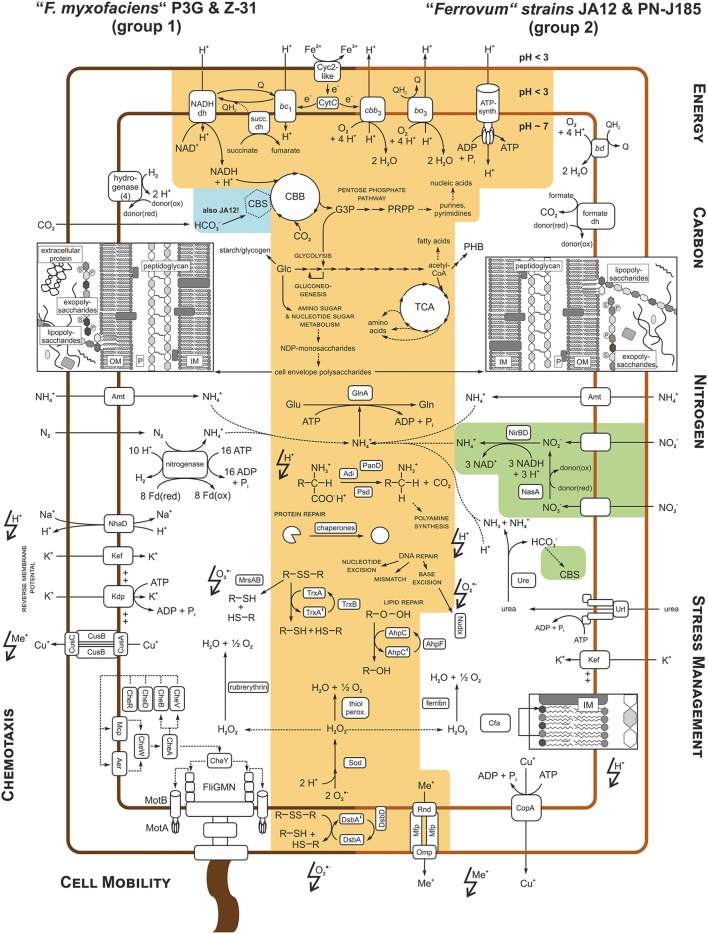
Comparison of the predicted metabolic potentials of “F. myxofaciens” strains P3G and Z-31 and the group 2 strains JA12 and PN-J185. The comparison of potential metabolic traits was focused on energy, carbon and nitrogen metabolism, strategies of stress management with regard to the chemical constraints of their natural habitats (acidic pH, lightning with proton; oxidative stress, lightning with superoxide radical; high metal loads, lightning with metal ion), as well as chemotaxis and motility. Orange areas show metabolic traits predicted to be shared by all four strains. Metabolic traits only predicted in group 2 strain JA12 are shown in green while traits that were only predicted in the “F. myxofaciens” strains and group 2 strain JA12 are colored in blue. For description see text and Supplementary Data 1. Genes predicted to be involved in these metabolic pathways are listed in Supplementary Table 3.